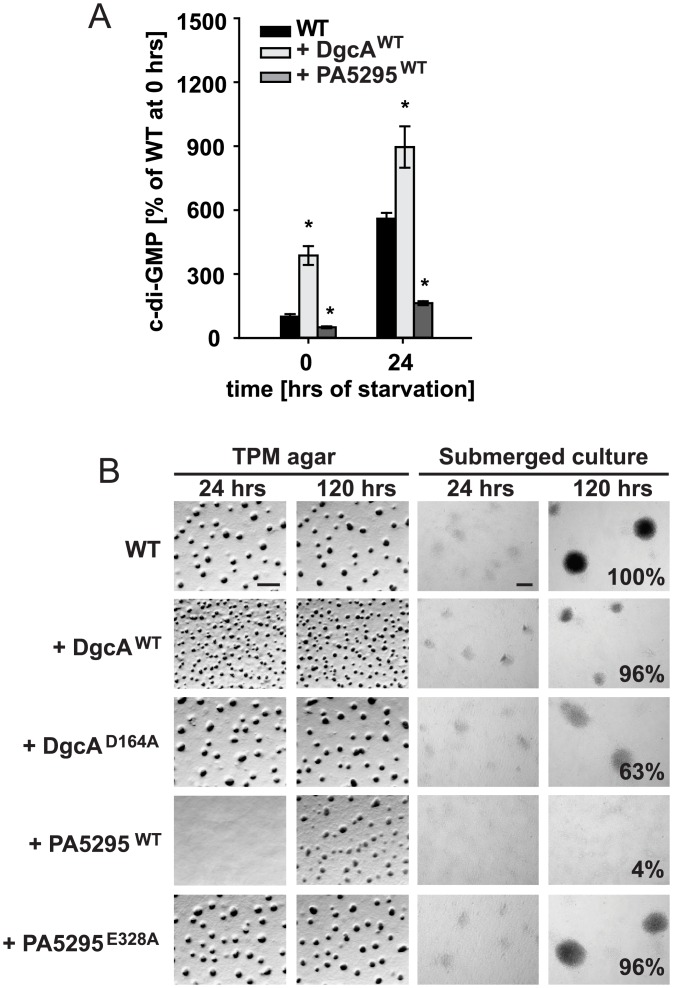
c-di-GMP level is important for development.(A) c-di-GMP levels in cells expressing the indicated proteins during starvation in suspension. The c-di-GMP levels are shown as mean ± SD from three biological replicates relative to WT at 0 hrs. * p < 0.05 in Student’s t-test comparing different mutants to the WT at the respective time points. Note that the data for WT are the same as in Fig 1. (B) Fruiting body formation and sporulation under two different starvation conditions. Numbers after 120 hrs of starvation in submerged culture indicate heat- and sonication resistant spores formed after 120 hrs of starvation in submerged culture in percentage of WT (100%) from one representative experiment. Scale bars, TPM agar 500 μm, submerged culture 100 μm.